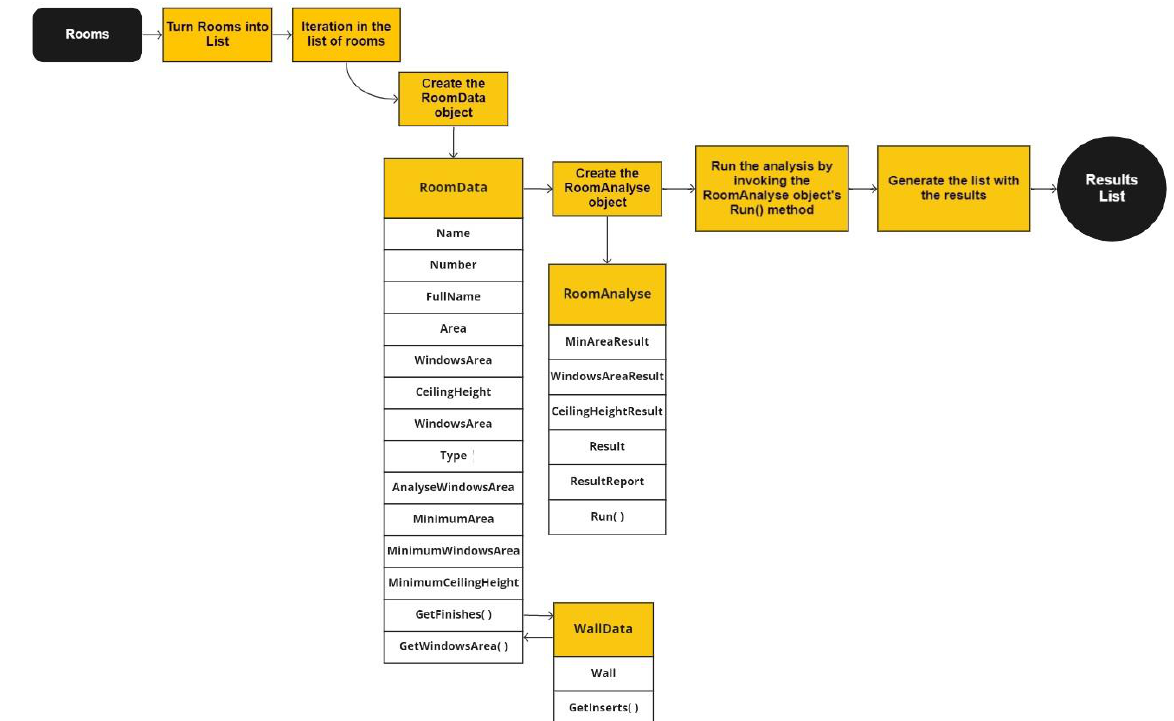
Figure 5. Room data information flow.